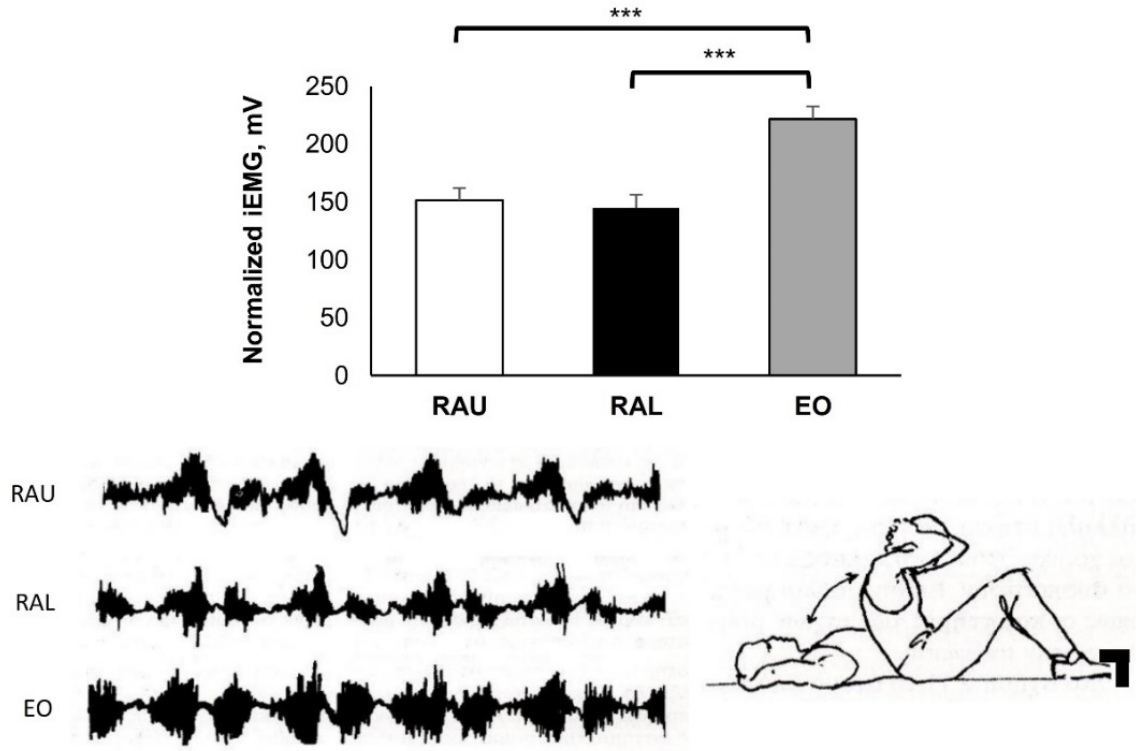
Figure 4. Hook lying with bent knees and support on the feet. Quick start; flexion and extension of the trunk five times. Group mean electric activity during the exercise. iEMG indicates surface electric activity. Raw EMG activity of the three muscles from one participant. RAU = rectus abdominis upper part; RAL = rectus abdominis lower part; EO = external oblique. Differences between muscles: *** p < 0.001.